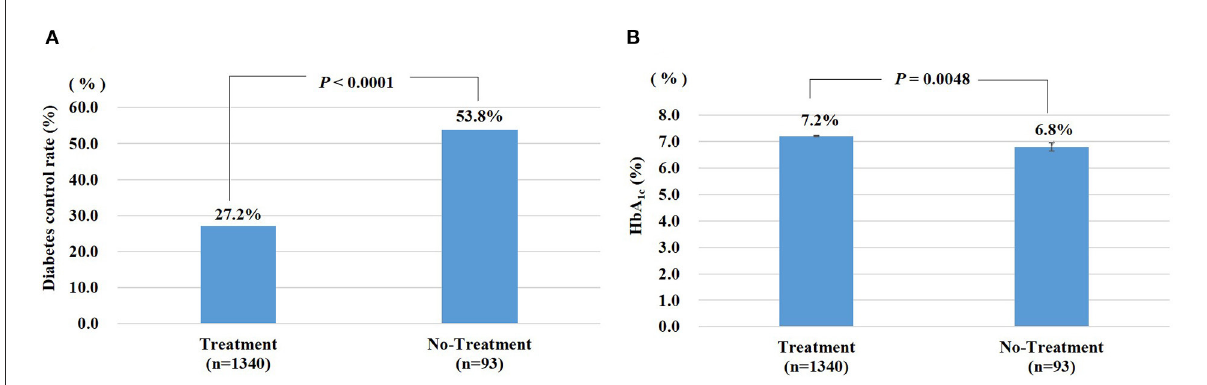
FIGURE2 (A) Diabetes control rate (%): percentage of diabetic patients whose HbA 1c is less than 6.5%. (B) HbA 1c was expressed as means ± standard error (STDERR). Treatment: Diabetic patients are defined as taking hypoglycemic agents or insulin. No-Treatment: Diabetic patients who are not taking hypoglycemic agents or